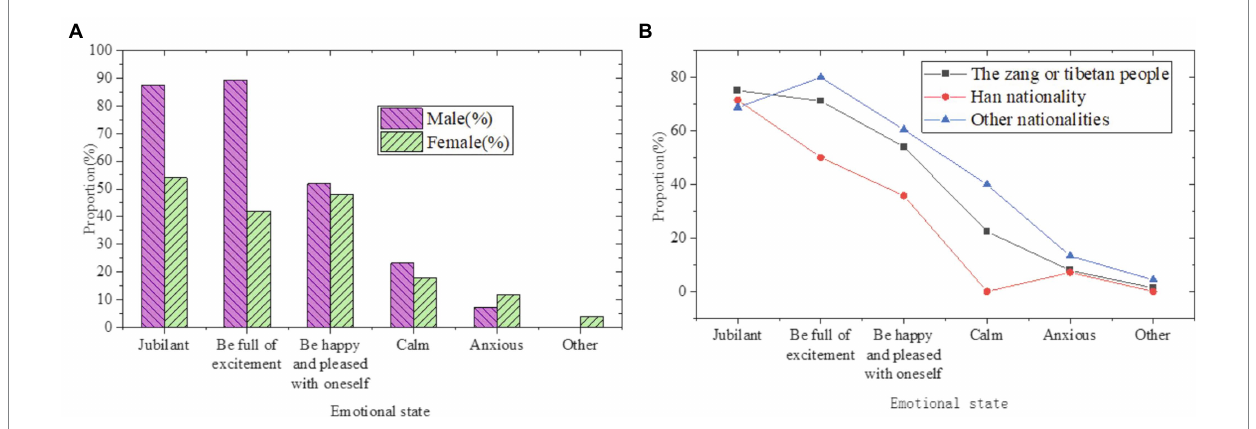
FIGURE 9 Statistics on the emotional status of students during the participation of Guozhuang dance and folk art ( A : by gender; B : by educational background).